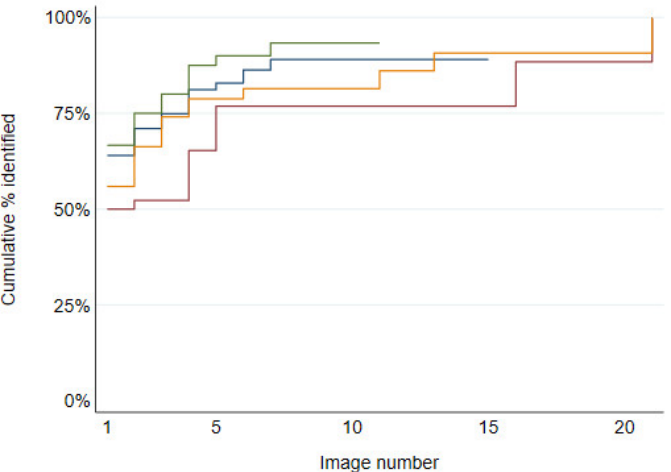
Figure 8. Cumulative percentages of observation events where the horse was identified by number of images from still image observation events in various habitats: riparian (green); open grassland (blue); woodland (orange); open disturbed woodland (red). Kaplan–Meier failure functions are graphed; these are equivalent to cumulative percentages of observation events where the horse was identified by the specified x -axis value if no observation events had been right-censored.